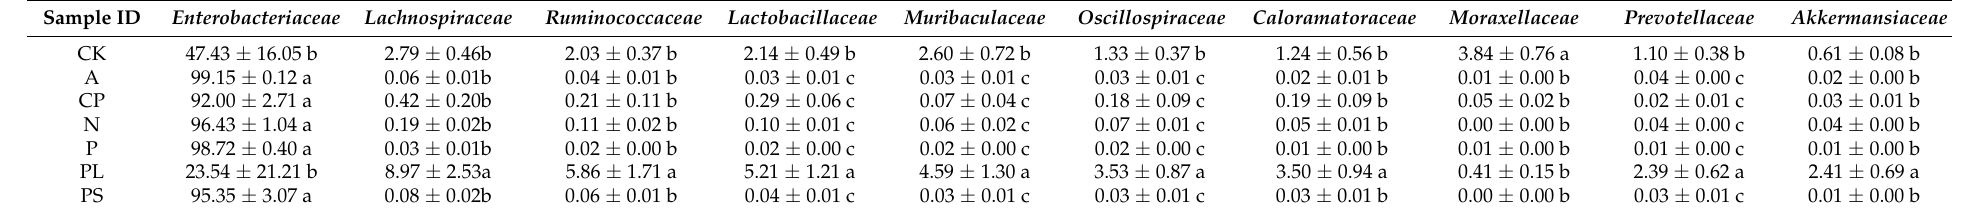
Table 3. The relative abundance of the top 10